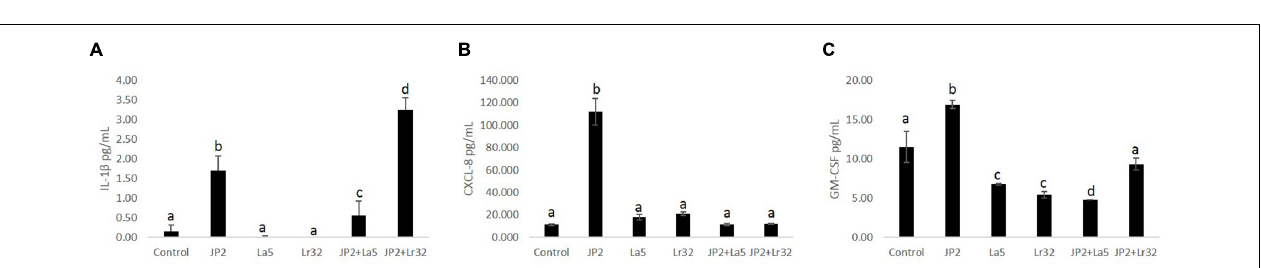
FIGURE 2 | A. actinomycetemcomitans (JP2) (A) and lactobacilli (B) adherent/internalized into OBA-9 mono-infected with A. actinomycetemcomitans (JP2), L. acidophilus La5 (La5), or L. rhamnosus Lr32 (L32) and co-infected with the pathogen and L. acidophilus La5 (JP2 + La5) or L. rhamnosus Lr32 (JP2 + L32) for 2 h. Data are expressed as the number of bacterial cells/well, as estimated by qPCR. ANOVA/Tukey, and different letters indicate statistical differences among groups ( p < 0.05).